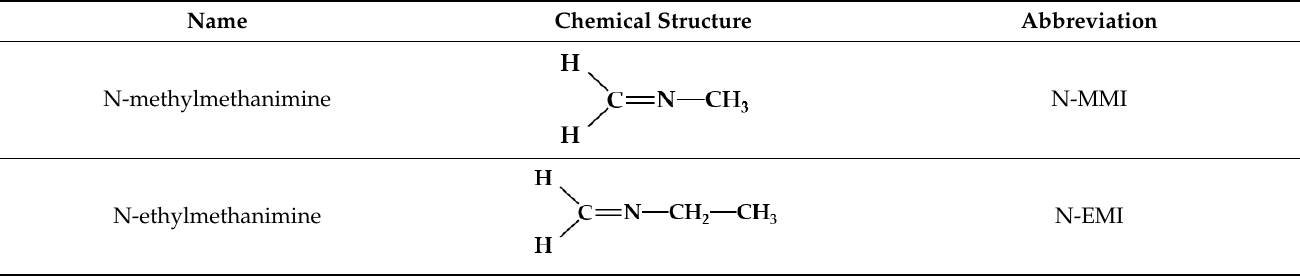
Table 1. Chemical names, structures and abbreviations of the new corrosion inhibitors investigated in the paper.